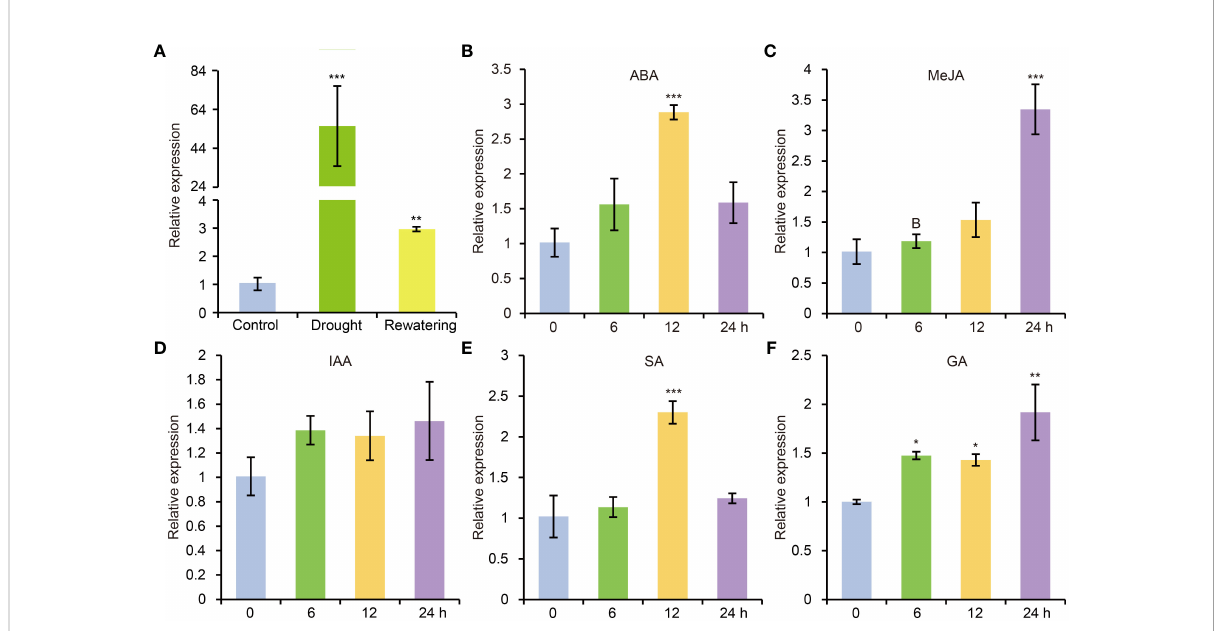
FIGURE 2 Expression analysis of GhCDPK60 via qRT-PCR after drought and hormone treatments. (A) Transcription level of GhCDPK60 after drought stress and rewatering treatments. (B-F) Expression patterns of GhCDPK60 in leaves of TM-1 seedlings sprayed with ABA, MeJA, IAA, SA and GA. Values represent the mean ± SE from three biological replicates. Statistically signi fi cant differences compared to 0 h (not-treated control). * P < 0.05, ** P < 0.01 and *** P < 0.001 by Student ’ s t